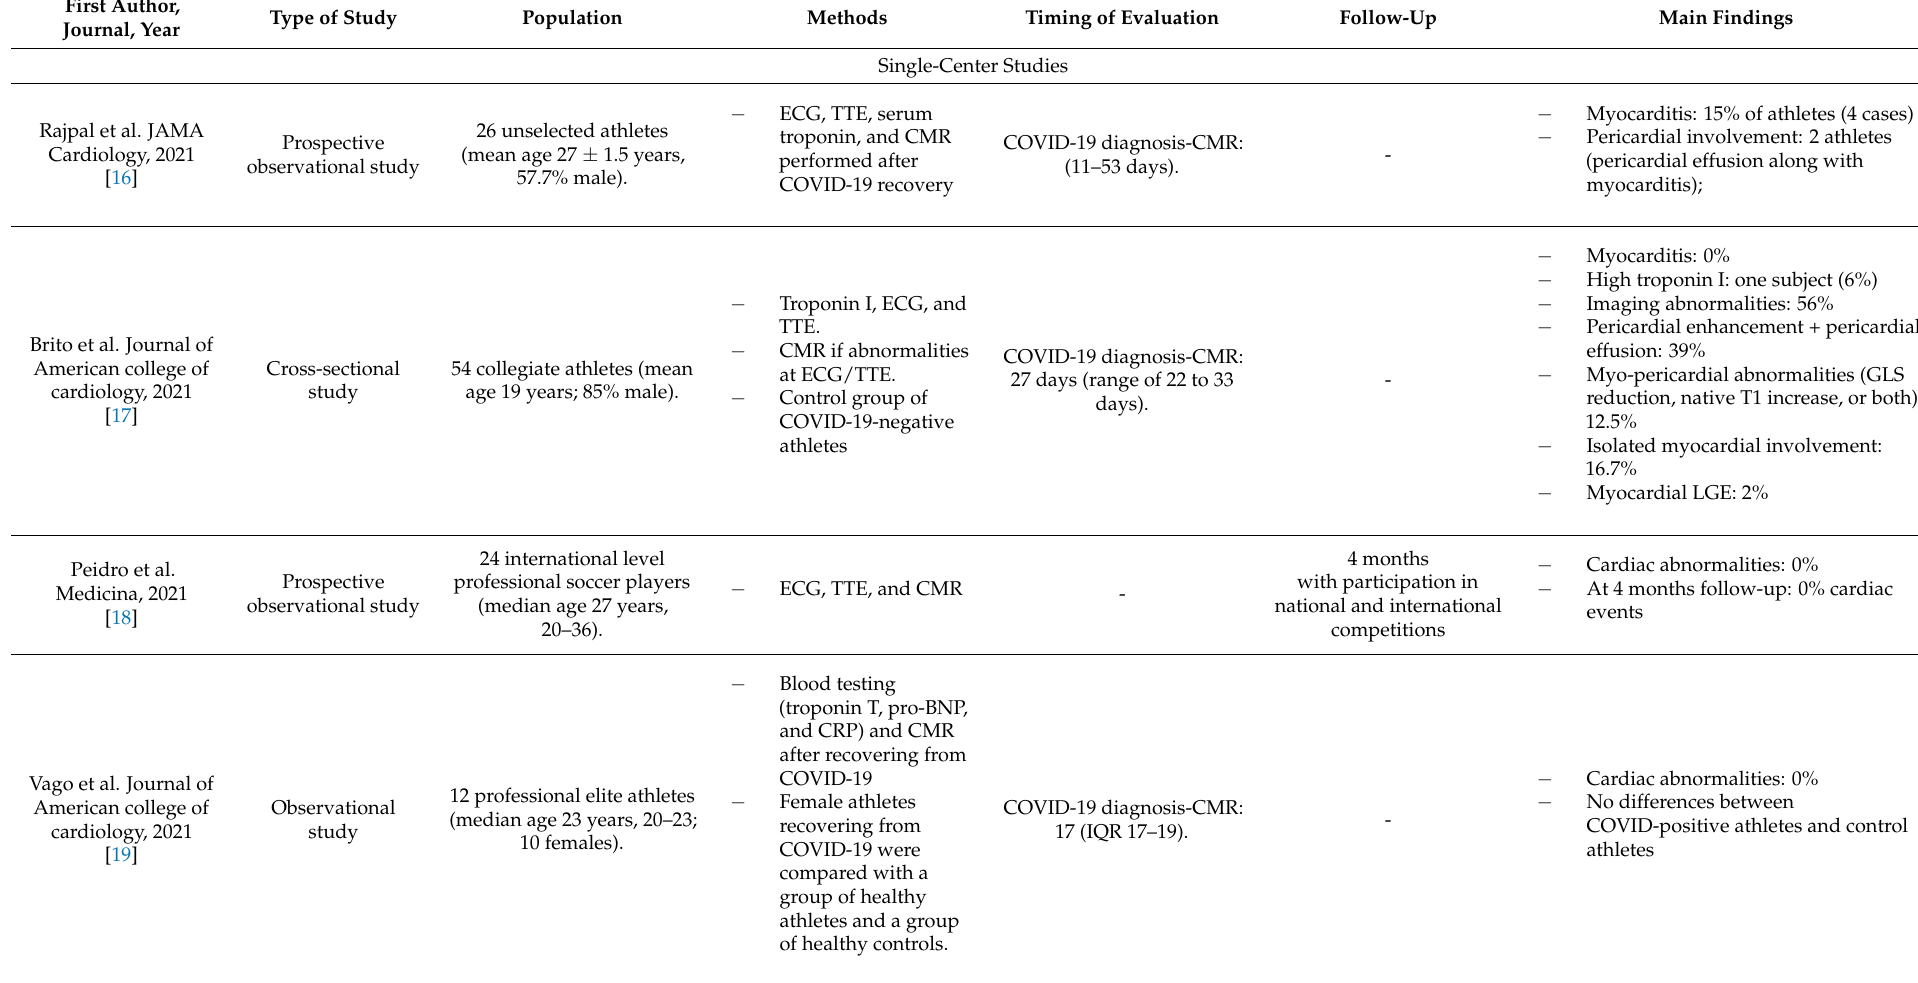
Table 1. Studies on cardiovascular involvement in athletes after SARS-CoV2